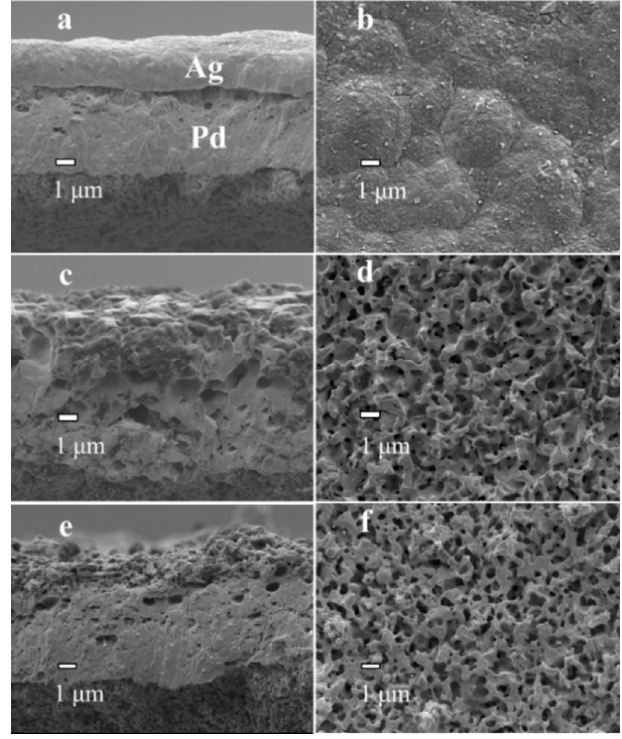
Figure 3. SEM images of Pd-Ag alloy layers: ( a , b ) PA-1 before alloying, ( c , d ) PA-1 after alloying under hydrogen at 823 K for 24 h and ( e , f ) PA-2 after alloying under nitrogen at 823 K for 24 h.